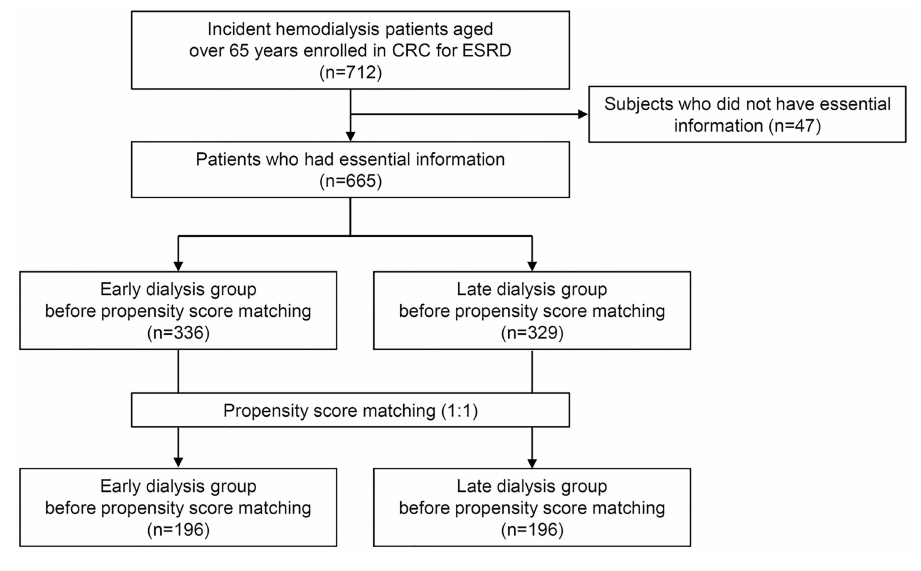
Fig 1. Flow chart of the